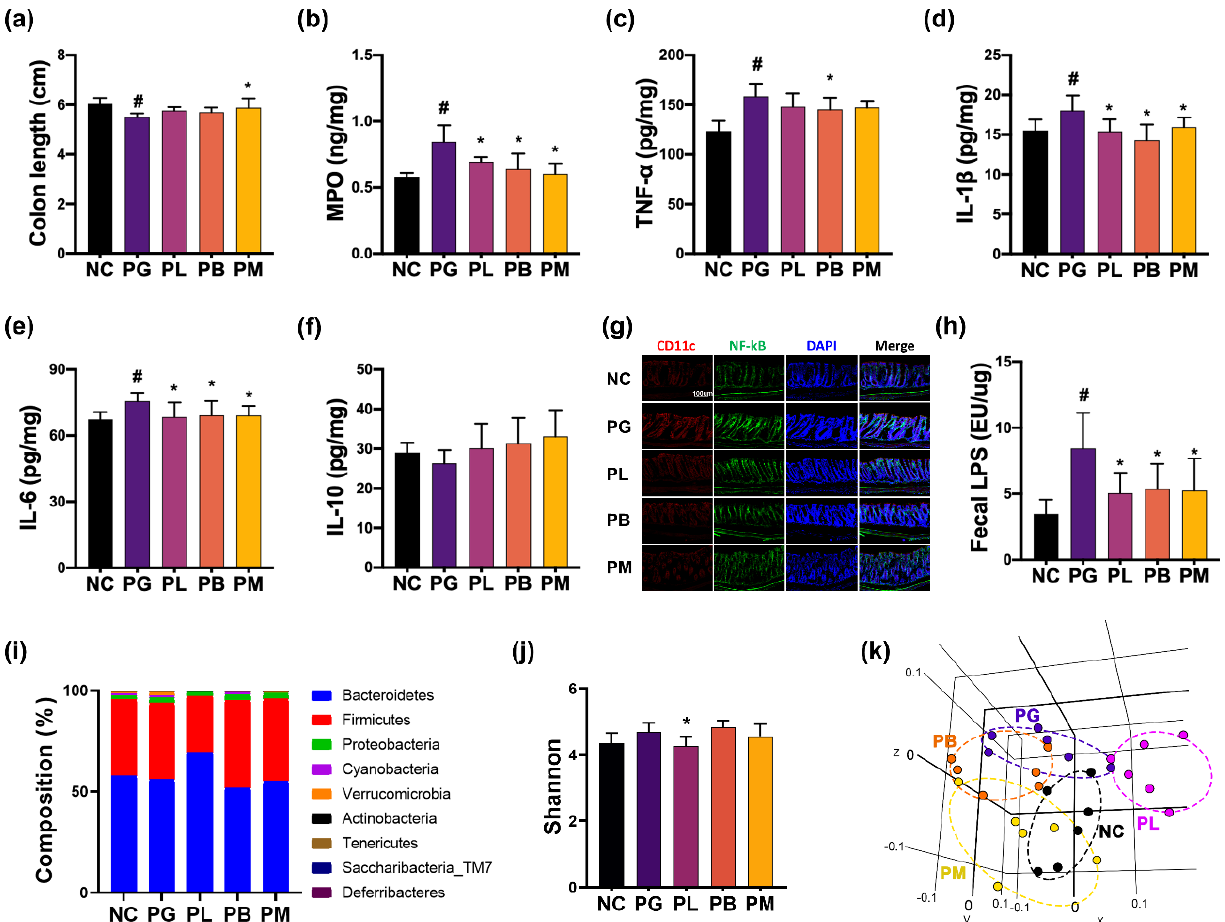
Figure 4. NK357, NK391 and NKc alleviated PG-induced colitis and gut microbiota dysbiosis in mice. Effects on colon length ( a ), MPO ( b ), TNF- α ( c ), IL-1 β ( d ), IL-6 ( e ), and IL-10 expression ( f ), and NF- κ B + CD11c + cell population ( g ). ( h ) Effects on fecal LPS level. Effects on gut bacterial composition: ( i ) phylum, ( j ) Shannon index ( α -diversity), and ( k ) β -diversity (principal coordinate analysis plot based on UniFrac). Data were indicated as mean ± SD ( n = 6). # p < 0.05 vs. NC. * p < 0.05 vs. PG.